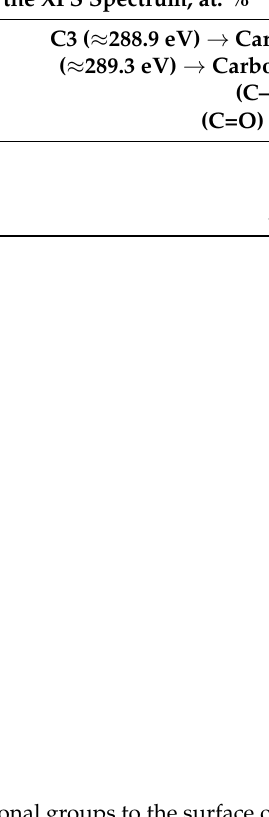
Table 6. Carbon composition of the surface of composites, depth 5–10 nm. Fraction of C1s in the XPS Spectrum, at. %